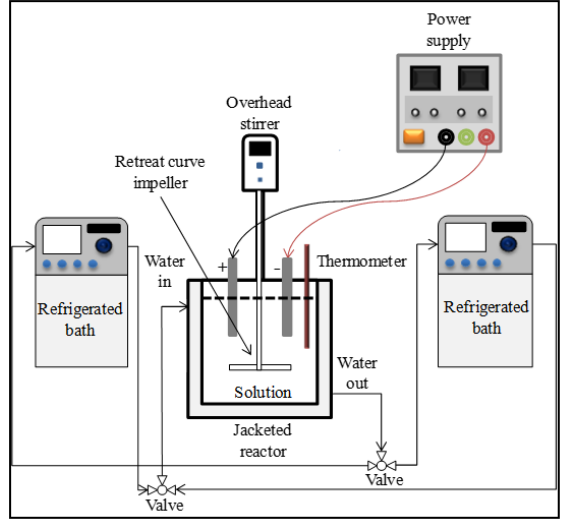
Figure 2. Schematic diagram for the electrocrystallisation experimental rig used in this study. Two refrigerated baths were used for isothermal crystallisation, ensuring that sudden cooling could be achieved.